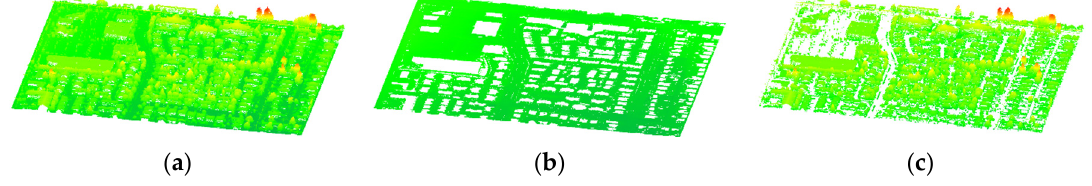
Figure 2. The example of the filtering result. ( a ) Raw point cloud; ( b ) Ground points; ( c ) Non-ground points after ground removal.